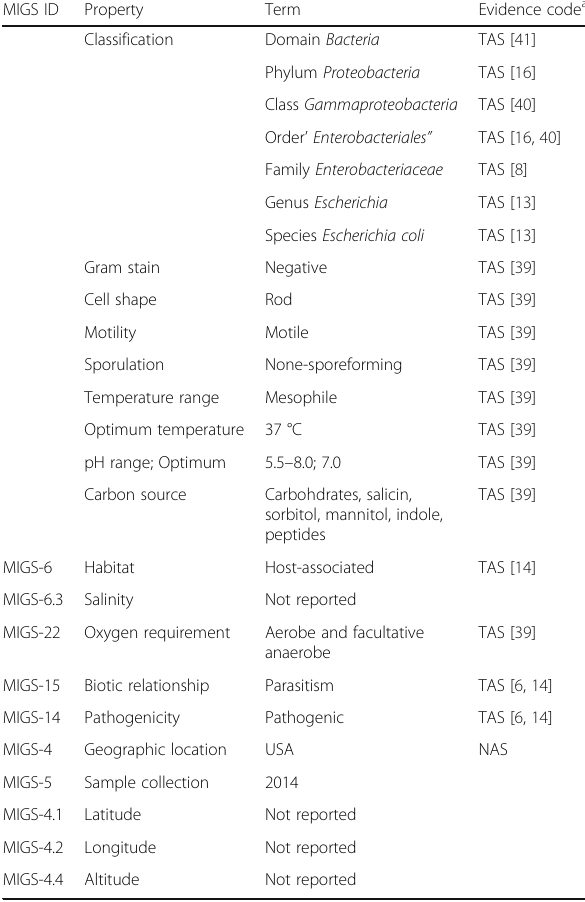
Table 1 Classification and general features of the E.